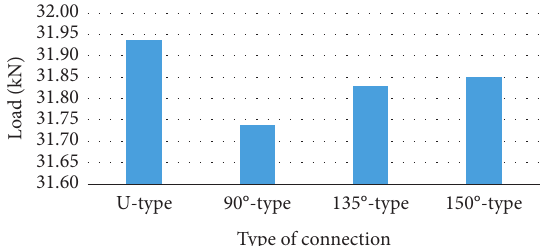
Figure 12: Effect of type of connection on the ultimate load ca- pacity of the connection with t s / t w equal to 1.